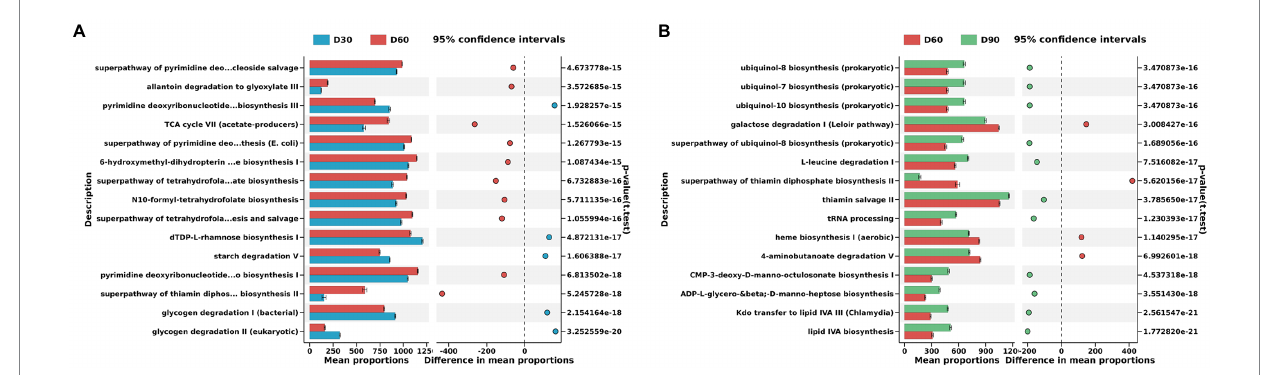
FIGURE 4 Differences in KEGG metabolic pathways of the flue-cured tobacco rhizosphere microbiota at different g transplantation stages. (A) . Differences in KEGG metabolic pathways of the flue-cured tobacco rhizosphere microbiota at the Day 30 and 60 transplantation stages. (B) . Differences in KEGG metabolic pathways of the flue-cured tobacco rhizosphere microbiota at the Day 60 and 90 transplantation